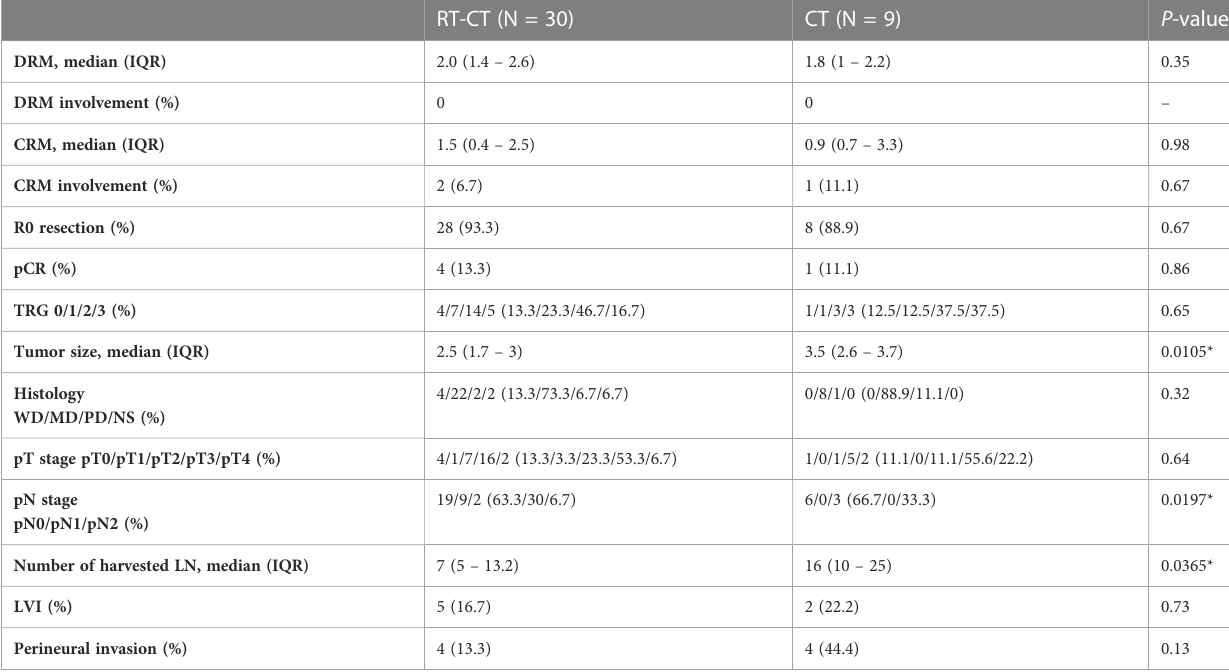
TABLE 4 Comparison between the RT-CT and CT groups in terms of the histopathologic characteristics of resected primary